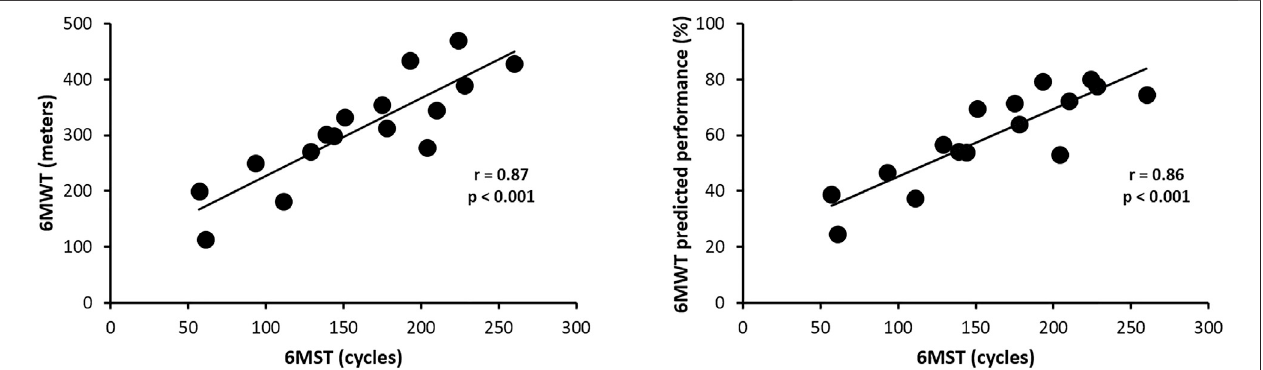
FIGURE 3 | Correlation of performances in 6MST and 6MWT in absolute values and predicted values. Abbreviations: 6MST, 6-min stepper test; 6MWT, 6-min walk test.